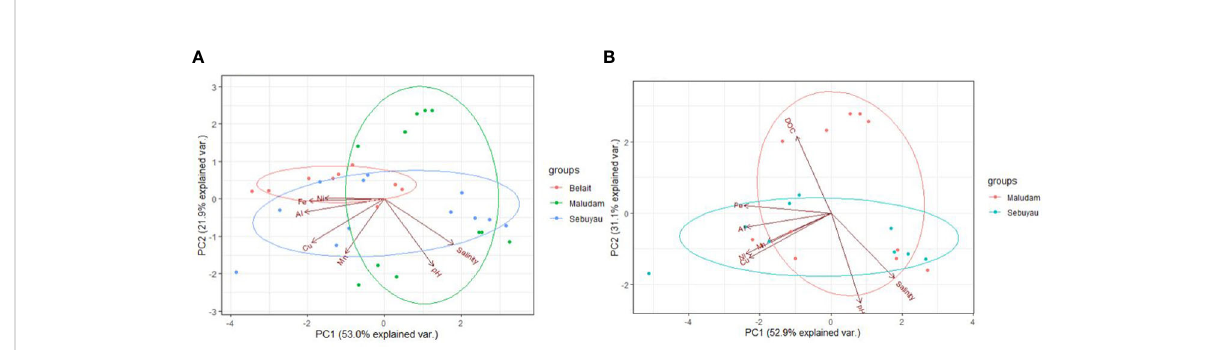
FIGURE 5 Principal Component Analysis showing the fi rst two principal component. (A) Trace elements in the three rivers without DOC data and (B) Trace elements and DOC in Maludam and Sebuyau rivers. PC1 and PC2 in plot (A) for trace elements accounts for 74.9% of the data, while PC1 and PC2 in plot (B) for trace elements and DOC accounts for 84% of the data respectively. The circles on the plots are visual aids for the sample